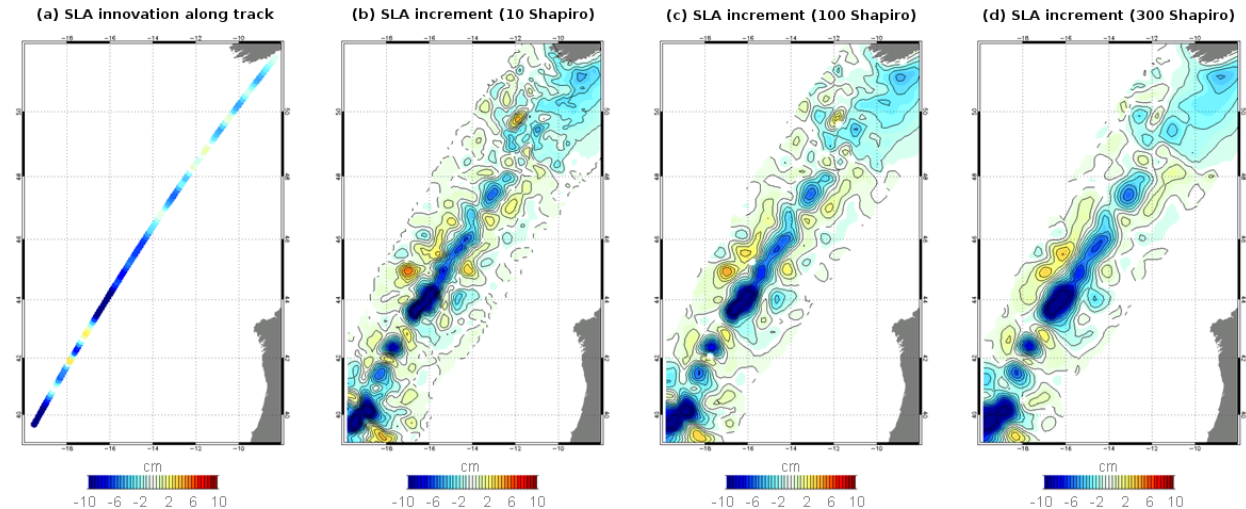
Figure 12. SLA innovation along a single assimilated track altimeter (a) . SLA increments with 10 (b) , 100 (c) and 300 (d) Shapiro passes as anomaly filtering. These experiments have been performed with a regional system at 1 / 36 ◦ . Unit is centimeters.